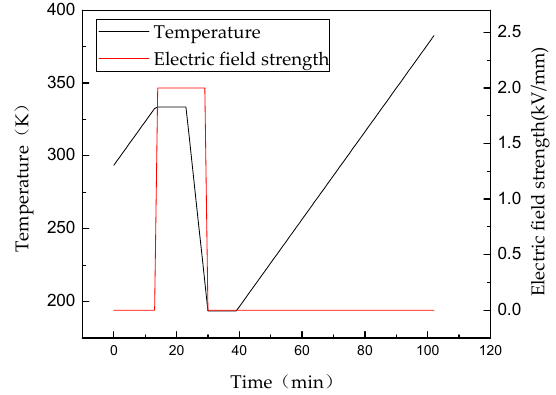
Figure 7. Schematic of thermal simulated current (TSC) measurement system.